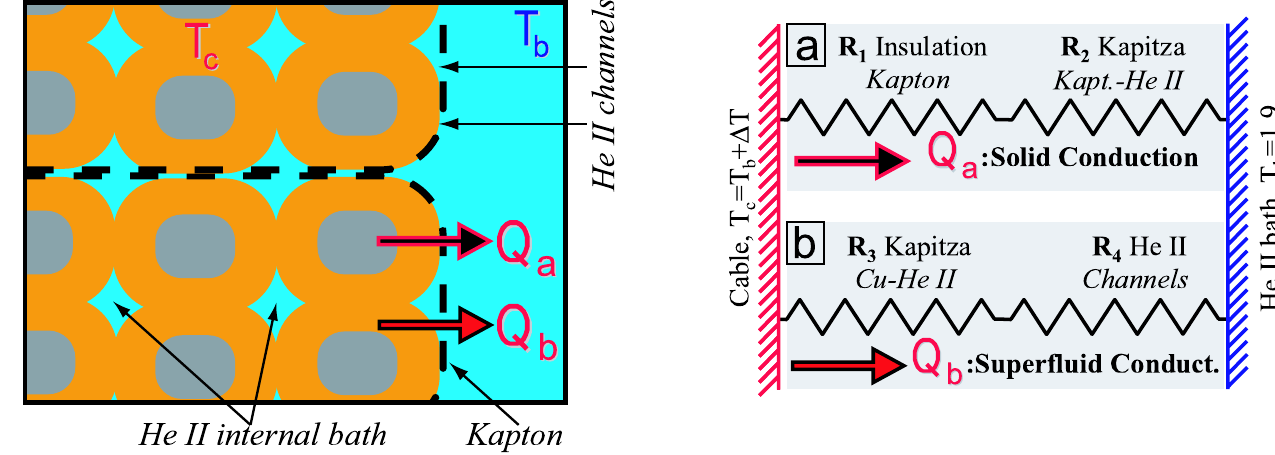
FIG. 2. (Color) Schematization of heat transfer path through porous